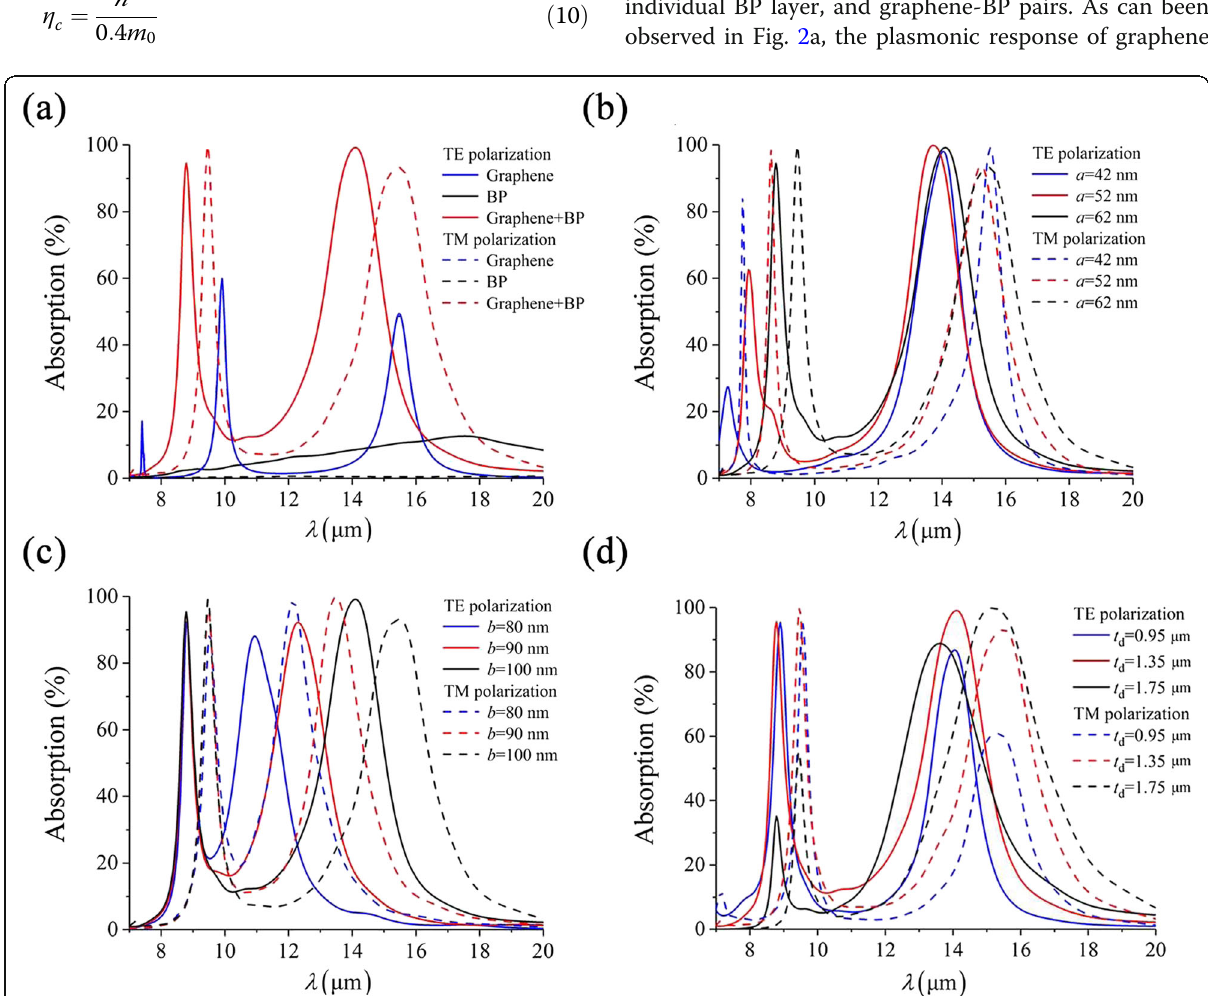
Fig. 2 a Comparison of plasmonic responses between monolayer graphene (blue solid curve and blue dashed curve are overlapped), monolayer BP and graphene-BP pairs, and absorption spectra with different a ( b ), b ( c ), and t d ( d ). The default parameters are a = 62 nm, b = 100 nm, t d = 1.35 μ m, t = 5 nm, and P = 250 nm, under normal